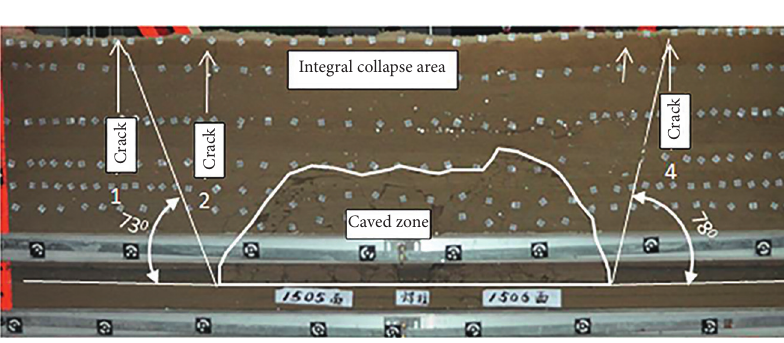
Figure 8: Crack distribution and overburden failure map of model mining.